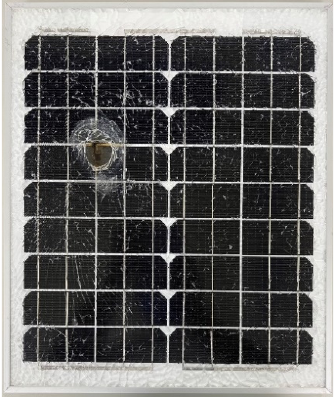
Figure 6 . Mild breakage of the PV module